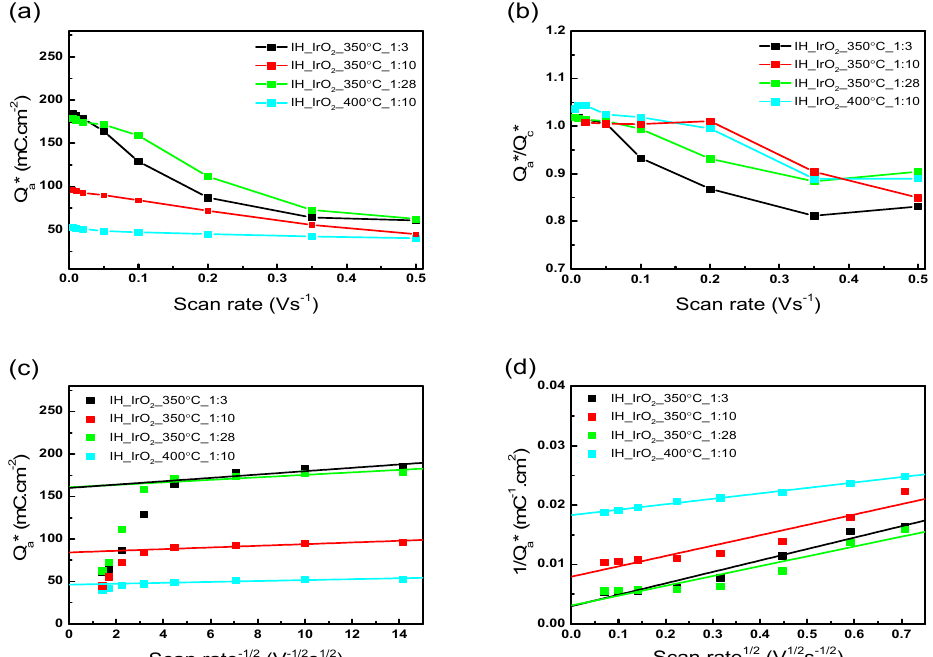
Figure 6. Estimation of electrochemical surface area (ECSA) for in-house IrO 2 electrocatalysts ( a ) Dependence of Q a * on the potential scan rate. ( b ) Influence of the potential scan rate on the Q a */Q c * ratio. ( c ) Extrapolation of Q a * as the potential scan rate → ∞ . ( d ) Extrapolation of Q a * as the potential scan rate → 0. Table 4. Extrapolated results for estimated ECSA and electrochemical